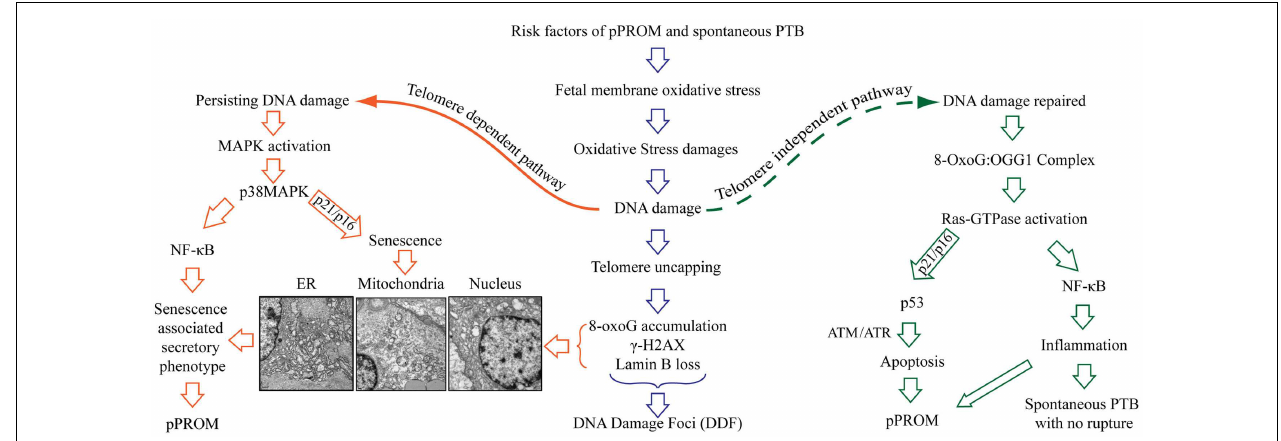
OS is too high to be controlled by antioxidant mechanisms of the intrauterine tissues, especially fetal membranes, a telomere-dependent pathway arises where either OS itself or damaged DNA and other cellular elements can trigger p38MAPK activation either through NF- κ B activation or direct cellular senescence.This is characterized by rounded, swollen organelles, and nuclear condensates. Additionally, senescing cells generate a unique set of biomarkers (senescence-associated secretory phenotype – SASP). SASP is characterized by cytokines, chemokines, matrix metalloproteinases,